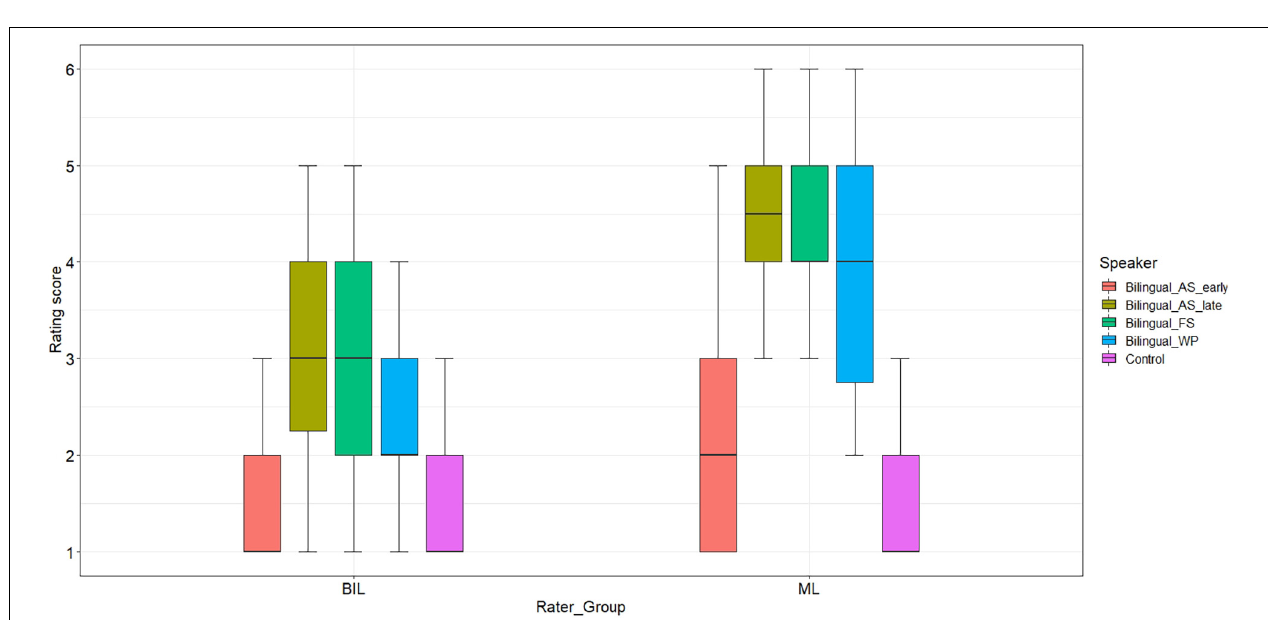
FIGURE 3 | Distribution of nativeness rating scores from 1 = certain of native speaker status to 6 = certain of non-native speaker status by rater group [Bilingual (BIL) raters vs. Monolingual (ML) raters] and individual speakers.